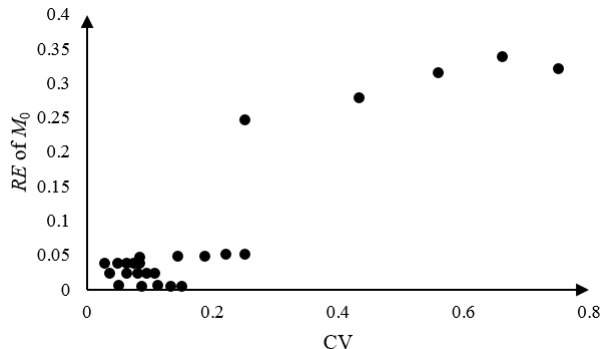
Figure 4. The correlation between CVs and RE of M 0 .